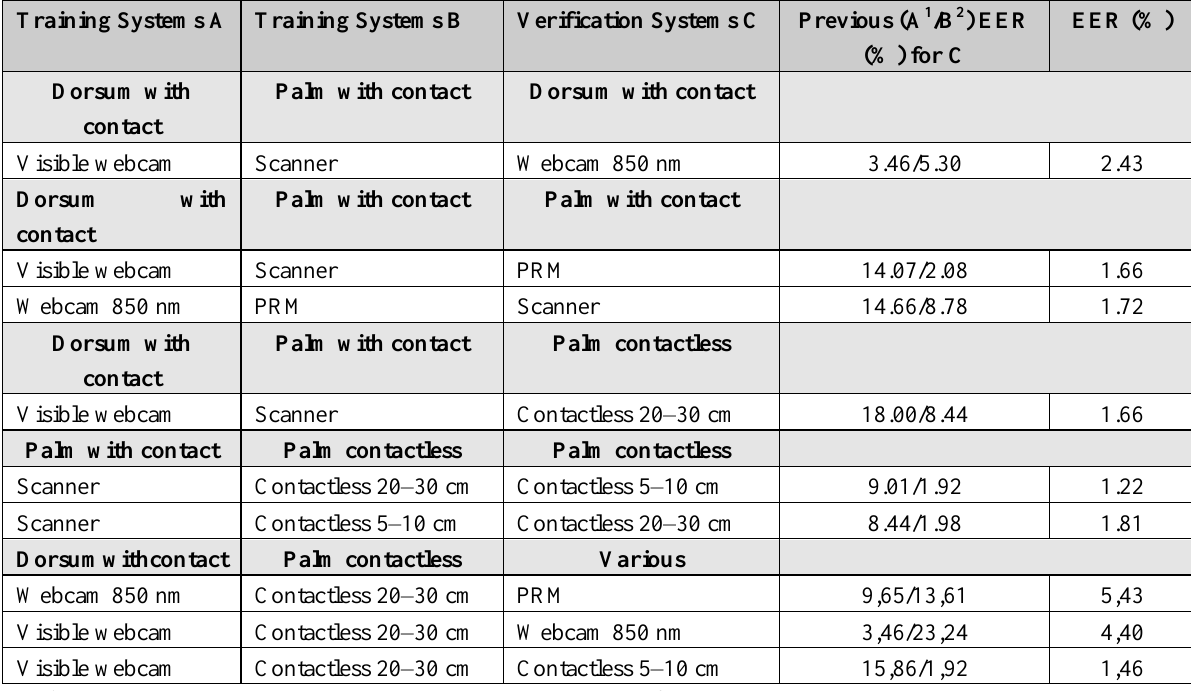
Table 8. Interoperability with two training sets and a combination at score level for finger geometry approach in terms of EER (%).